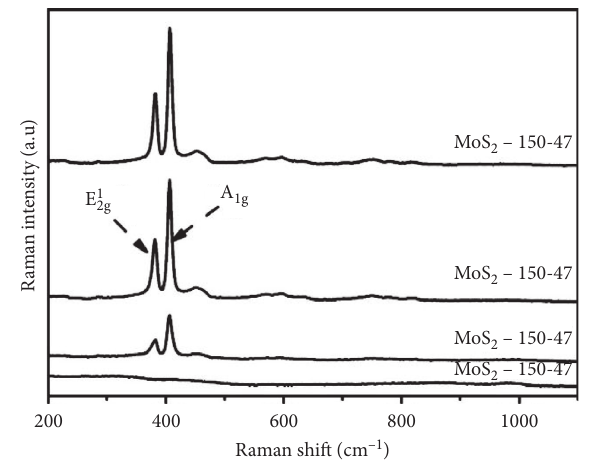
Figure 10: Typical Raman spectra of MoS